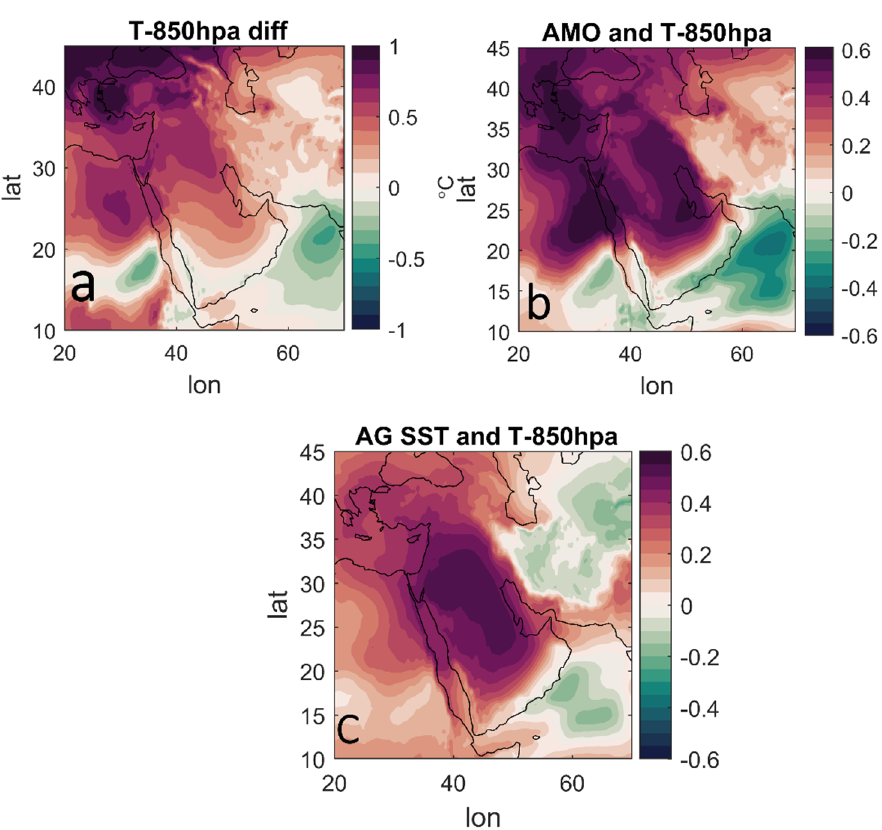
Figure 8. Same as Figure 7, but for the surface temperate.